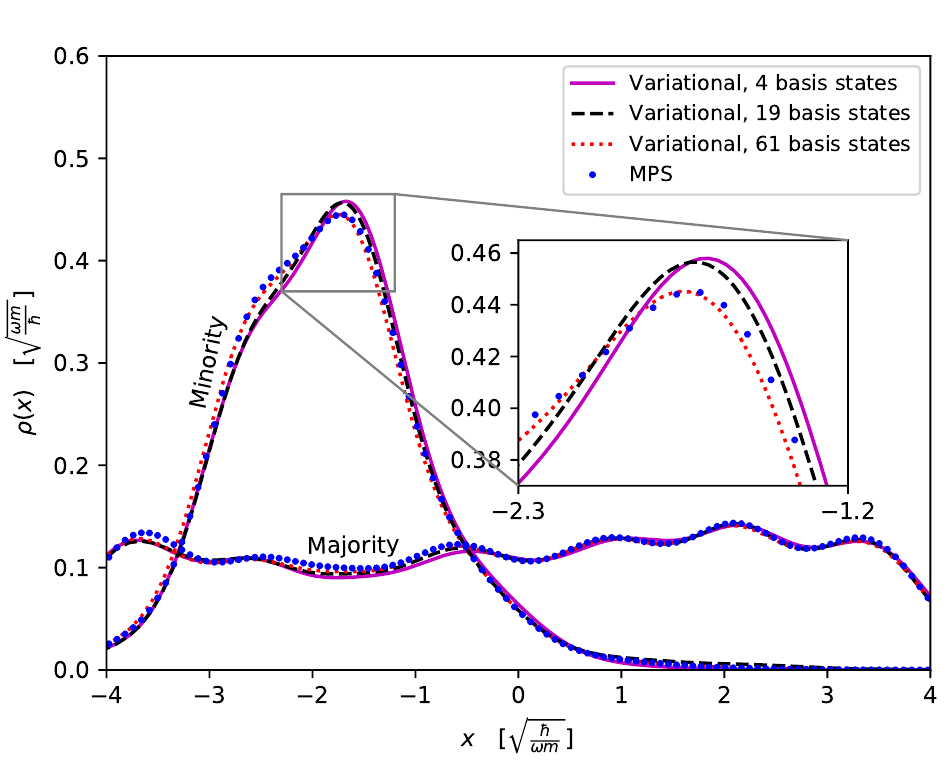
(cid:113) m = 10 in the double ħ h 3 ω